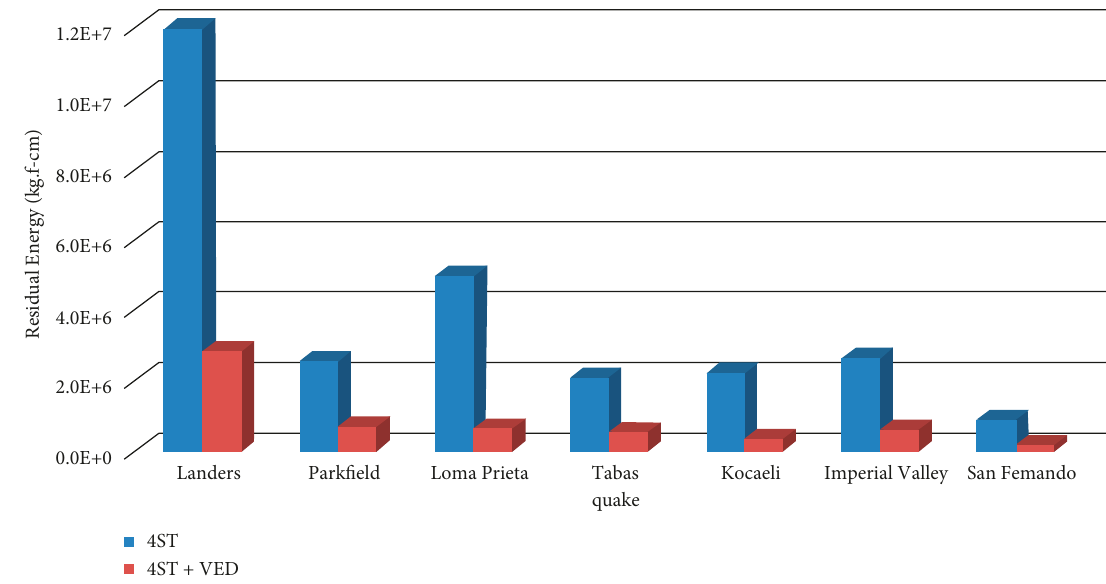
Figure 12: Residual energy diagram in a 4-story frame under near-field records, in two modes with and without dampers.